Question: Express in one sentence what the figure is showing.
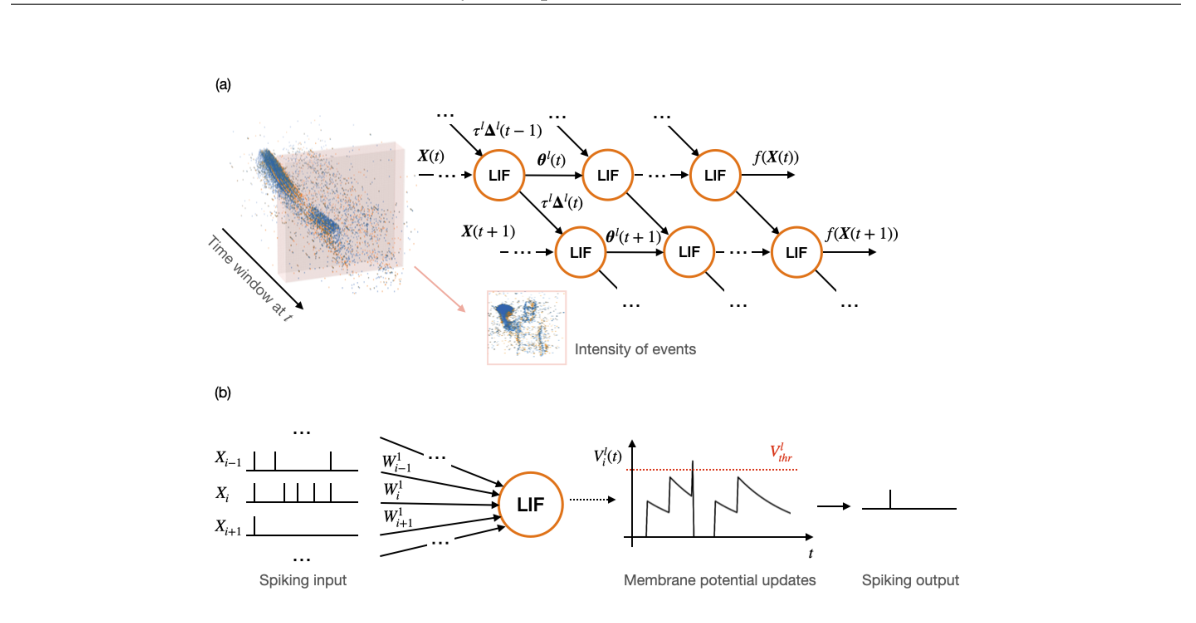
Answer: (a) Forward propagation in SNN. The input events X(t) stimulate neurons to generate spikes over the time. The output f(X(t)) can respond when a sufficient number of events are received within a specific time window. θ(t) and τ∆(t) represents the spatial and temporal information at t, respectively. (b) The state update of one LIF neuron at input layer during forward propagation process. The weight W l i influences the current contributing to the membrane potential V l i (t). The threshold V l thr determines the threshold level of V l i (t) required to generate the spikes.